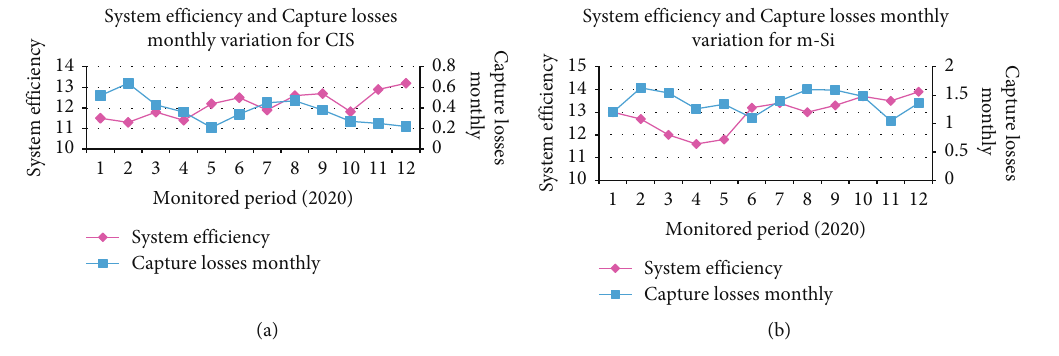
Figure 8: Capture loss and system e ffi ciency of (a) CIS and (b) m-Si.